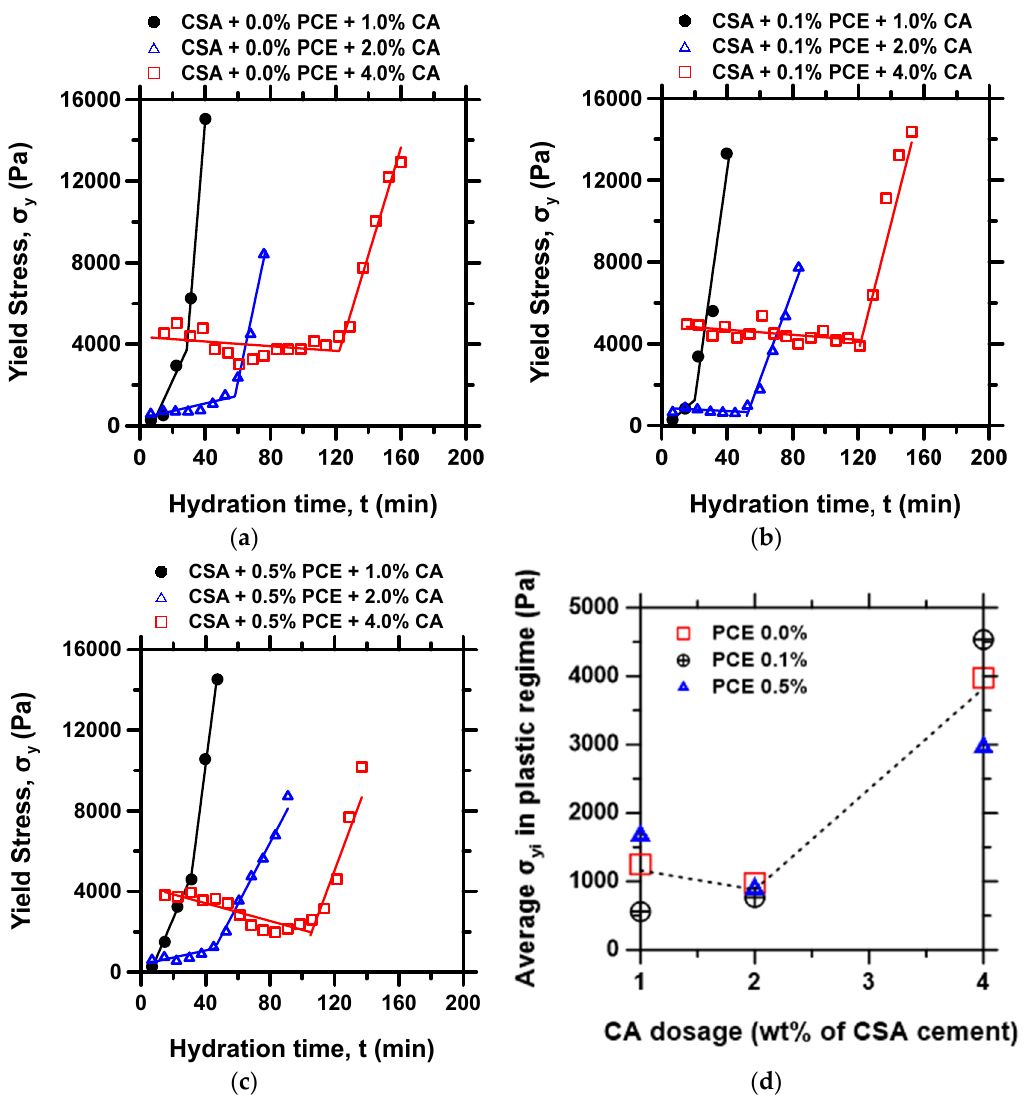
Figure 3. Time-dependent yield stress evolution for CSA cement pastes containing ( a ) 0% PCE, ( b ) 0.1% PCE, ( c ) 0.5% PCE, and ( d ) average yield stress at the flowability regime as a function of admixture dosage.